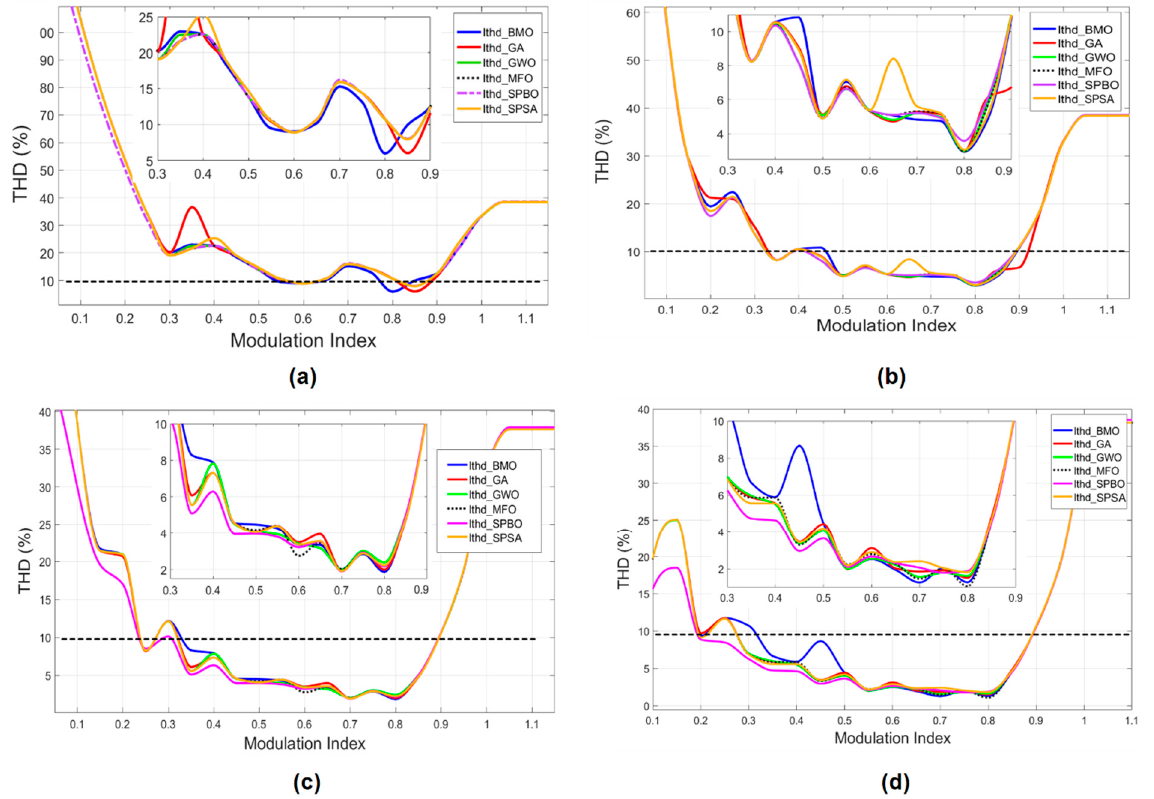
Figure 5. THD variations versus modulation indexes for MLI with ( a ) 7 − level, ( b ) 11 − level, ( c ) 15 − level, and ( d ) 19 − level applied to suggested metaheuristics.